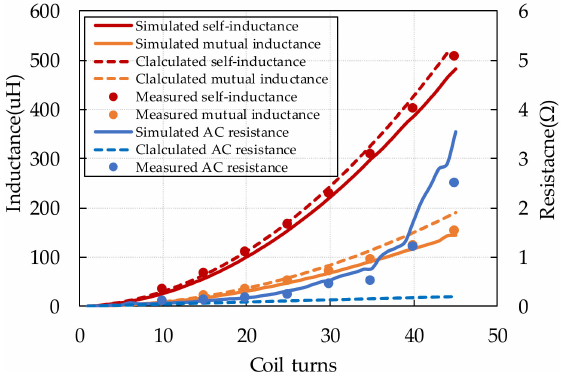
Figure 13. Relationship between coil-turns and coil-system parameters with fixed inner and outer